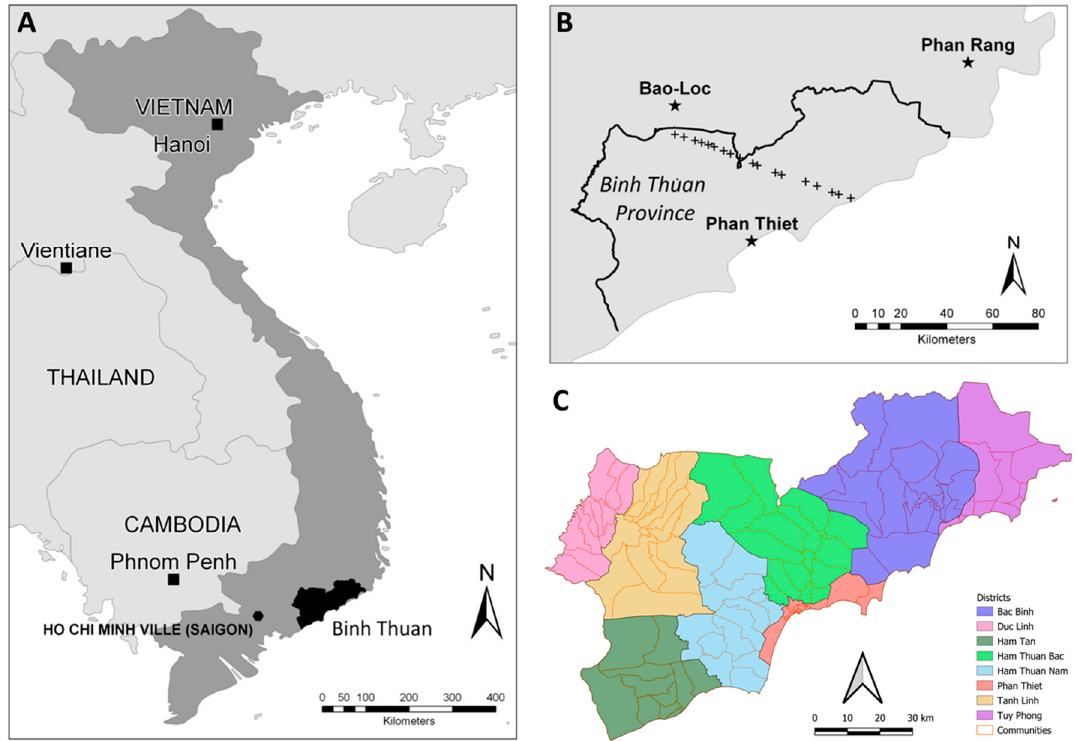
Figure 2. ( A ): Location of Binh Thuan province in Vietnam, ( B ): location of the three synoptic meteorological stations ( (cid:70) ) and the transect ( + ), ( C ): location of districts and communities.